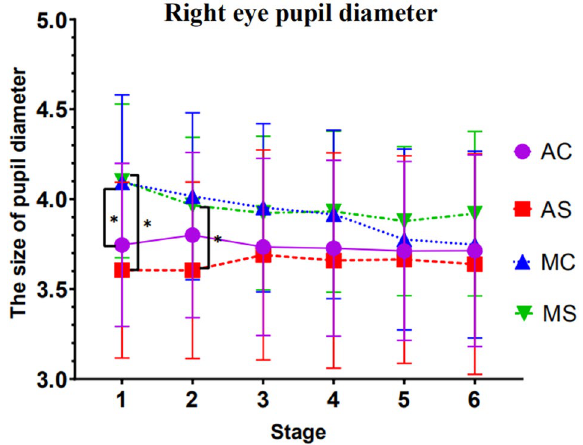
Figure 5. Trend in pupil diameter in the right eye (Note: Vertical bars represent standard errors, * p < 0.05).